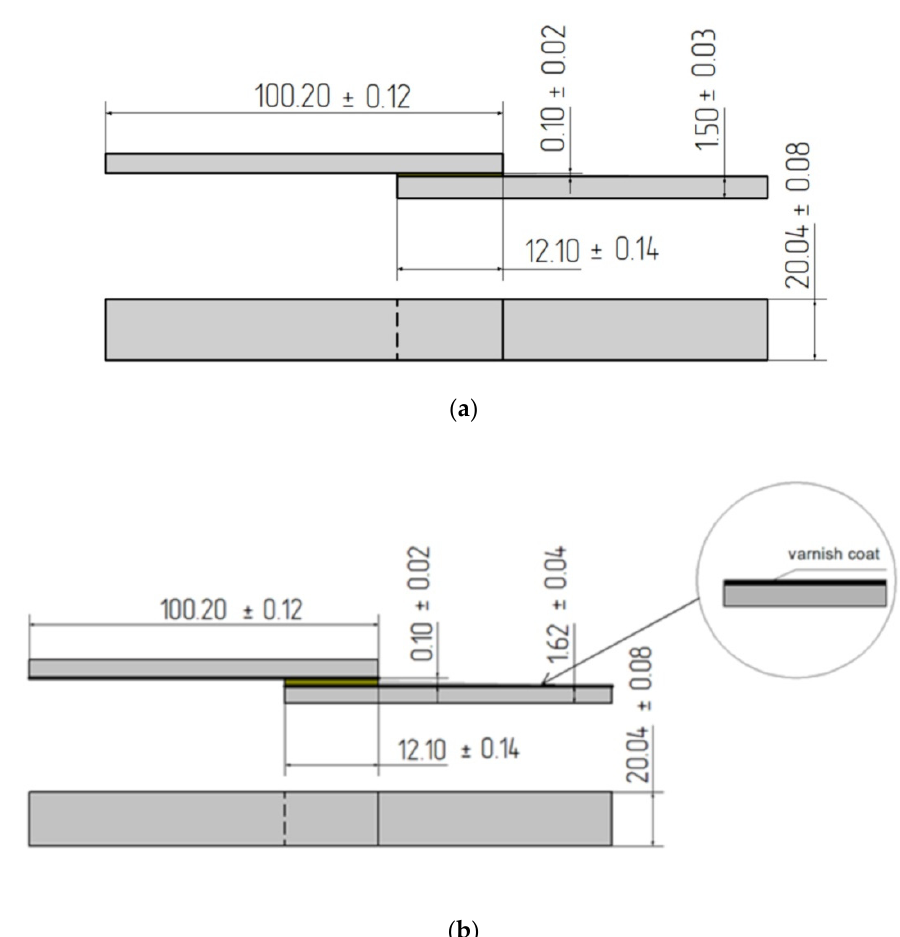
Figure 2. Scheme of single-lap bonded joints samples: ( a ) reference; ( b ) with varnish coat (dimensions in mm).